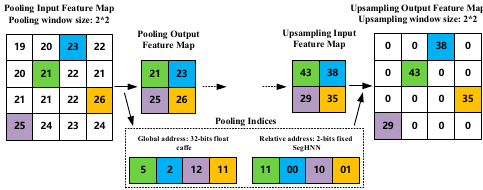
Figure 6. Global and Relative Pooling indices.